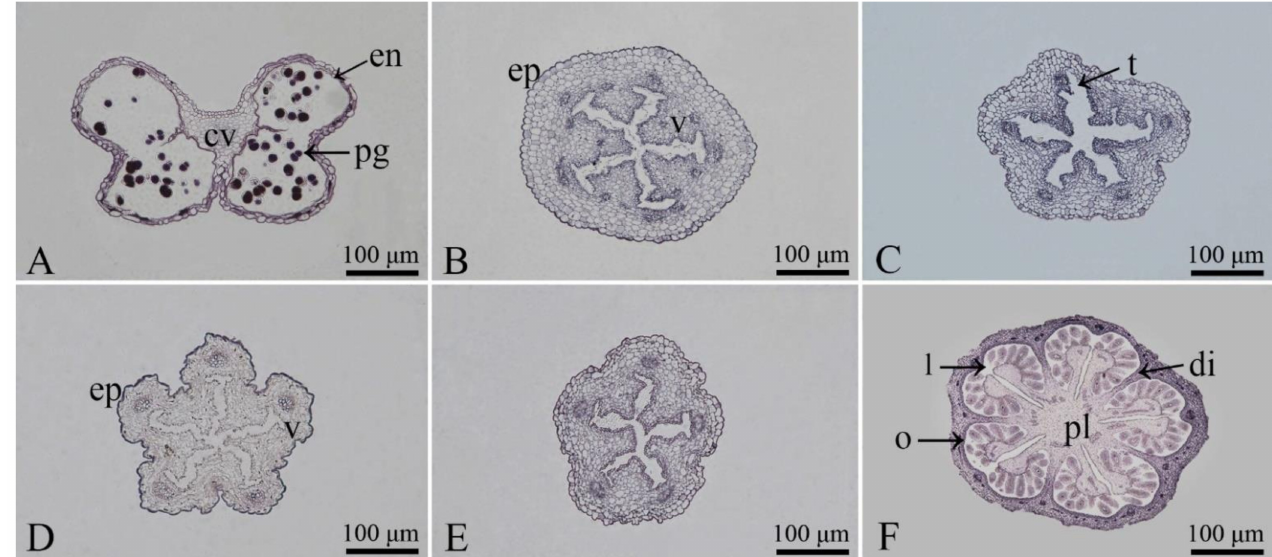
Figure 2. Paraffin section of floral organs. ( A ): anther; ( B ): stigma; ( C ): upper part of the style; ( D ): middle part of the style; ( E ): lower part of the style; ( F ): ovary. cv: connective vascular bundle; en: endothecium; pg: pollen grains; ep: epidermis; v: vascular bundle; t: transmitting tissue; l: locule; o: ovary wall; pl: placenta; di: